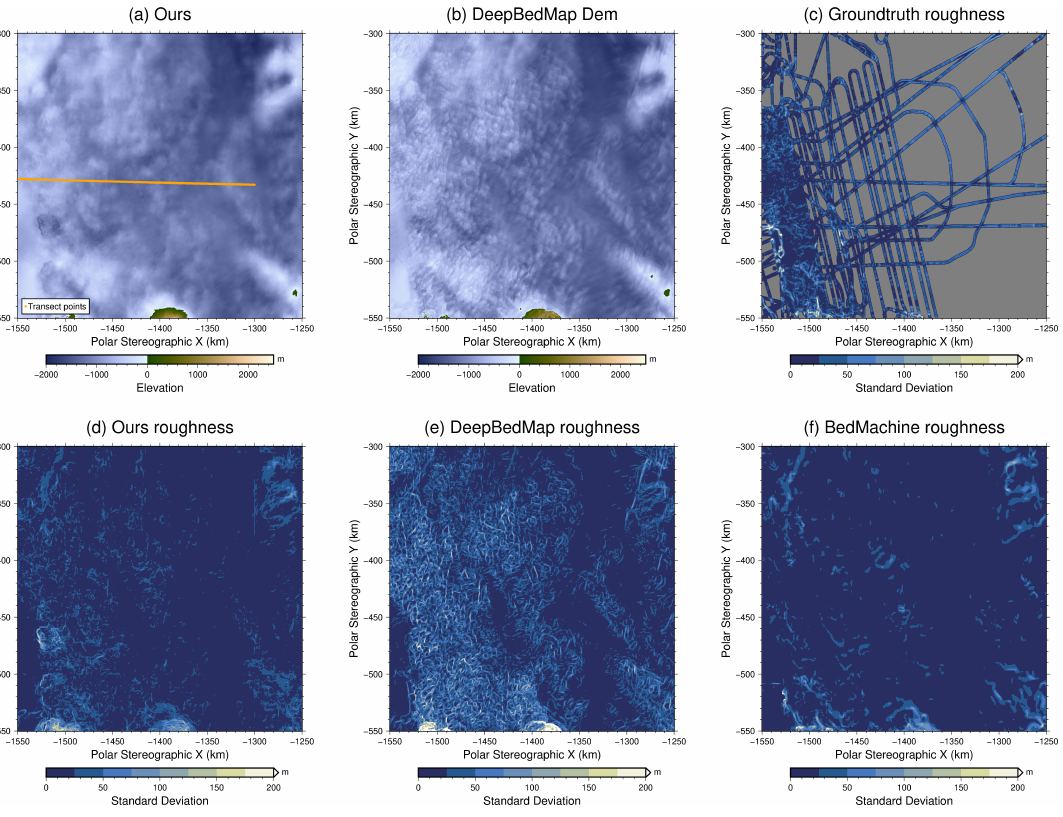
Figure 9. Spatial 2D view of grids over Thwaites Glacier, West